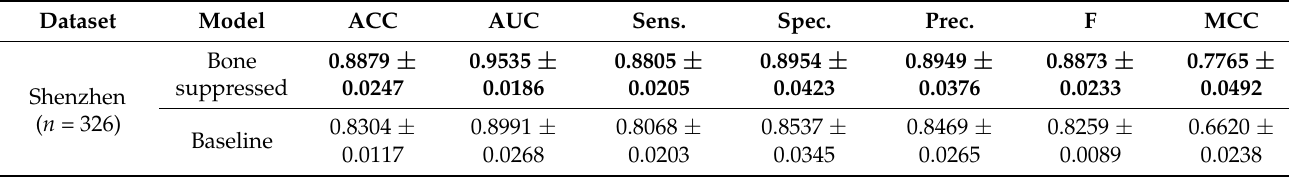
Table 4. Mean performance achieved by the cross-validated models using the bone-suppressed and non-bone-suppressed (baseline) CXR instances of the Shenzhen and Montgomery TB CXR dataset. Acc = Accuracy; Sens. = Sensitivity; Spec. = Specificity; Prec. = Precision; F = F-measure. One-way ANOVA is performed using the MCC values obtained by the baseline and bone-suppressed cross-validated models to analyze for the existence of a statistically significant difference in performance. Bold numerical values denote superior performances in corresponding columns for the Shenzhen and Montgomery TB CXR collections. The performance of the bone-suppressed models is statistically significantly superior ( p < 0.05) to the baseline models in all